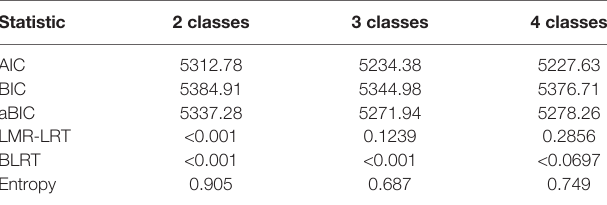
TABLE 3 | The latent class analysis of risk factors.